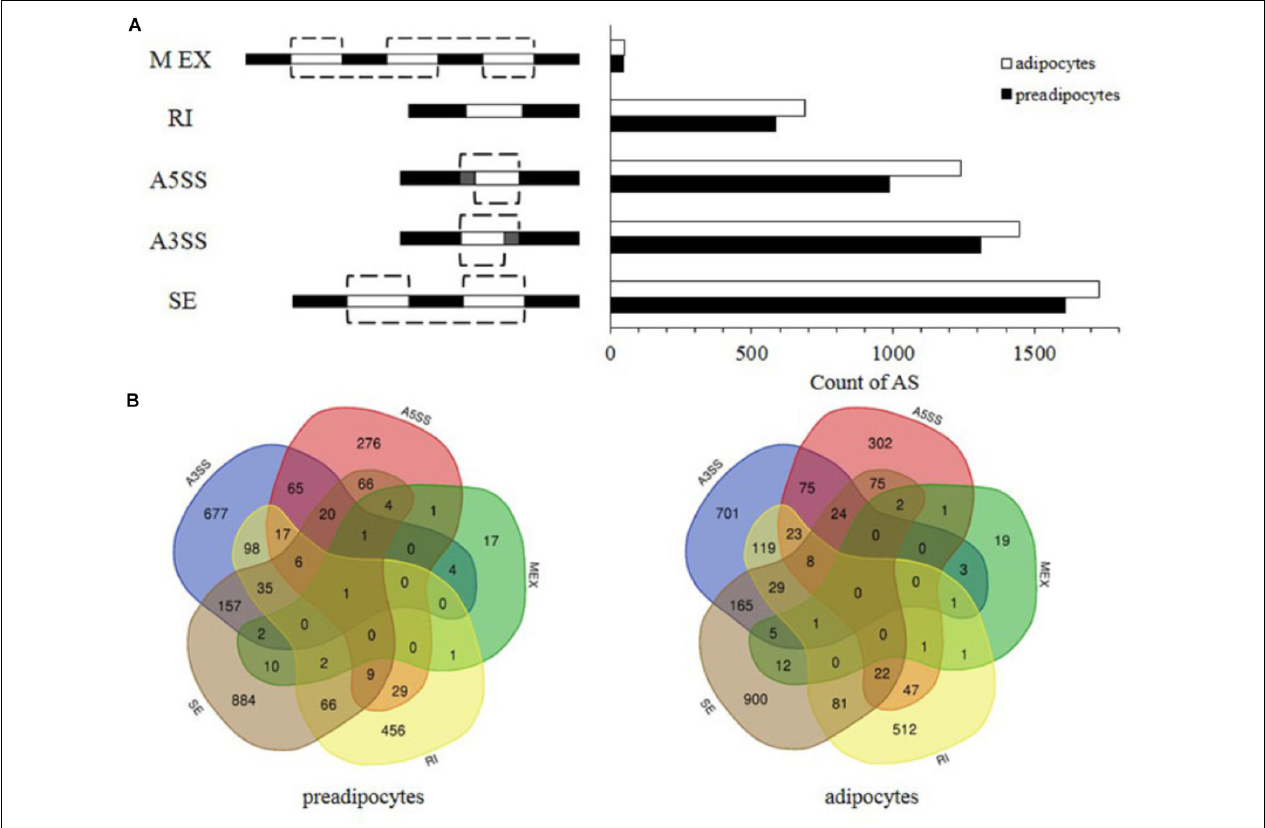
FIGURE 2 | Comparison of AS patterns in preadipocytes and adipocytes. (A) Number of AS events in preadiopocytes and adipocytes. (B) Overlap of five types of AS genes in preadipocytes and adipocytes.